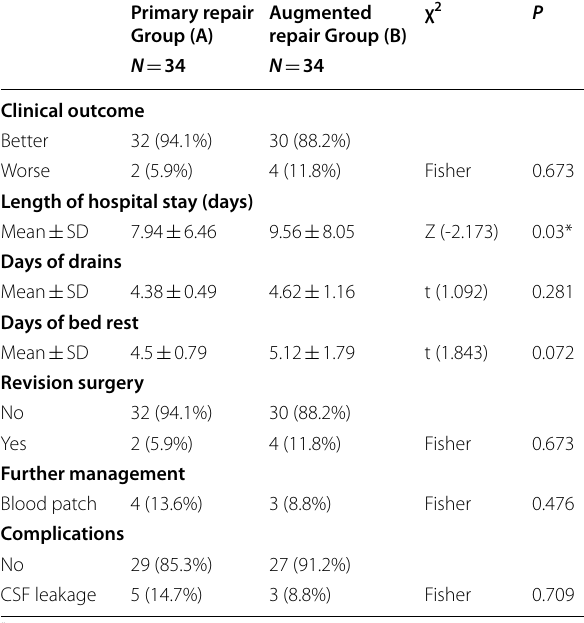
* T independent sample t-test p < 0.05 is statistically